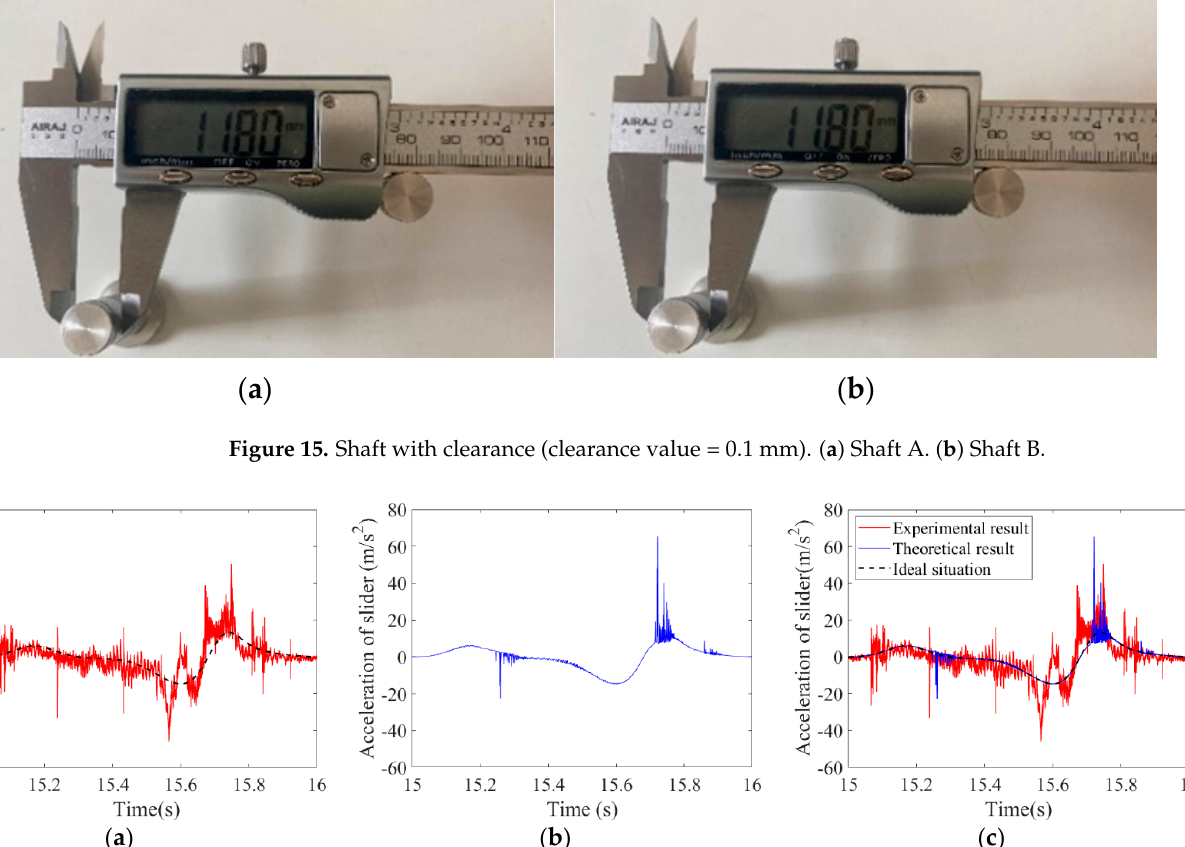
Figure 14. Structure diagram of the 2- DOF nine–bar mechanism testbed. ( a ) Normal axonometric drawing. ( b ) Lateral view. 1—Frame, 2—Support plate, 3—Crank 1, 4—Crank 4, 5—Rod 2, 6—Rod 3,